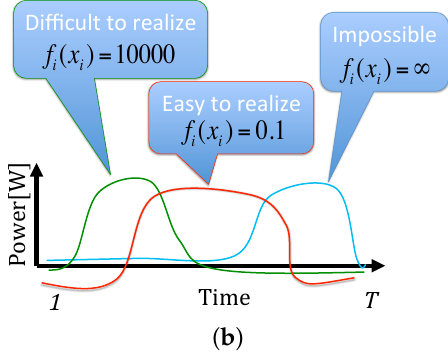
Figure 3. Prosumer community coordination. ( a ) Prosumer community and the associated x i ) and agent cost f i ( x i ) . The coordinated variable x i represents the power community cost g ( ∑ N i = 1 consumption of agent i ; ( b ) The agent’s cost function f i ( x i ) measures the difficulty to achieve x i , which can be associated to quality of life (QoL), physical constraints and economic